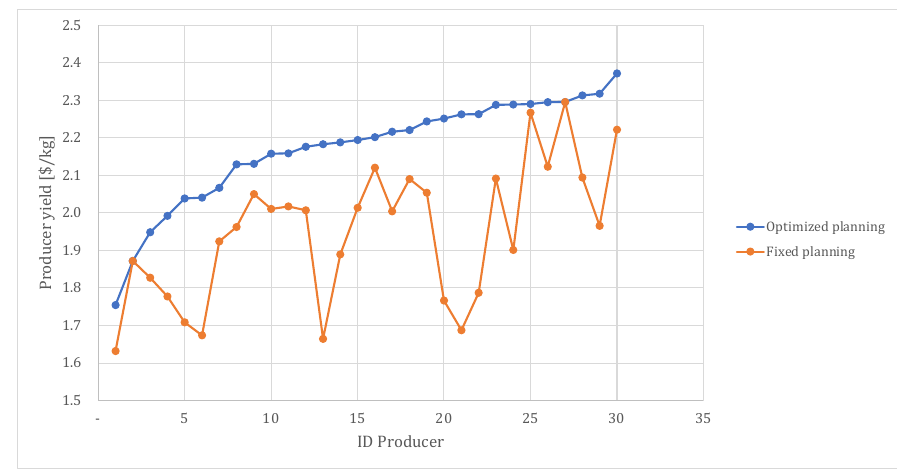
Figure 10. Producers’ yield benchmark.